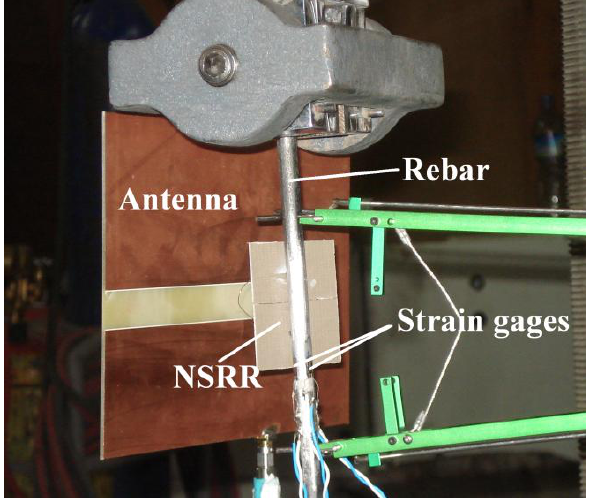
Figure 6. The rebar and sensor elements shown on the high-force mechanical